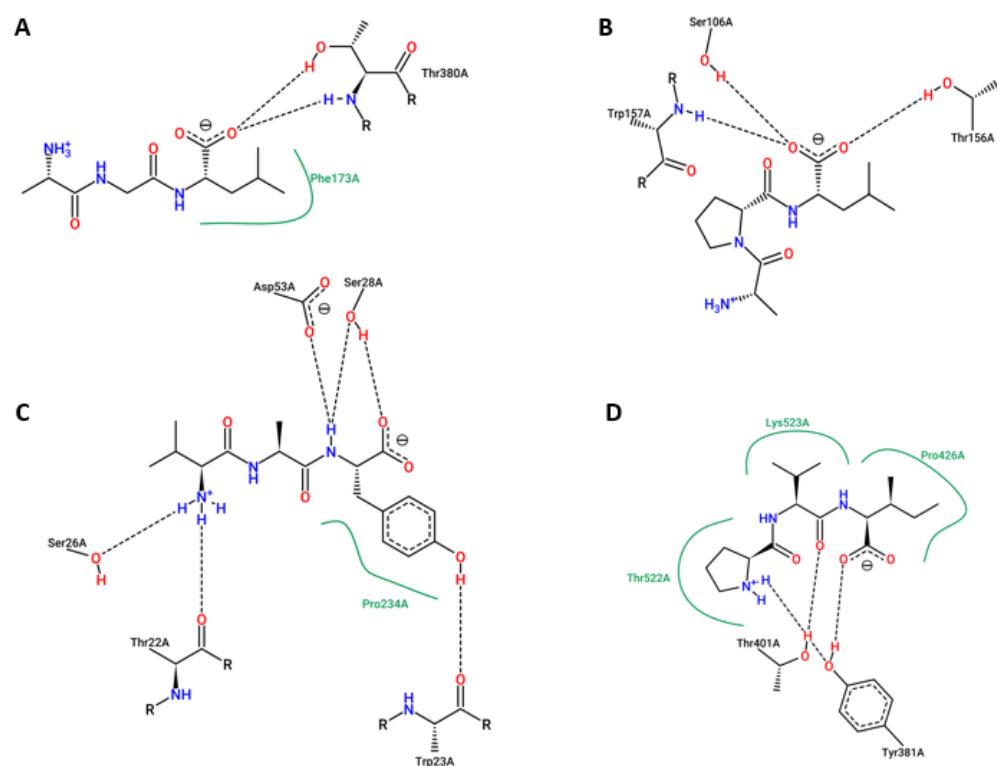
Figure 6. HPEPDOCK docking interaction of ( A ) peptide AGL with cyclooxygenase-2 (PTGS2, P35354), ( B ) peptide AIF with inhibitor of apoptosis protein 3 (XIAP, P98170), ( C ) peptide IIW with angiotensin I-converting enzyme (ACE, P12821), and ( D ) peptide PVI with dipeptidyl peptidase IV (DPP4, P27487).